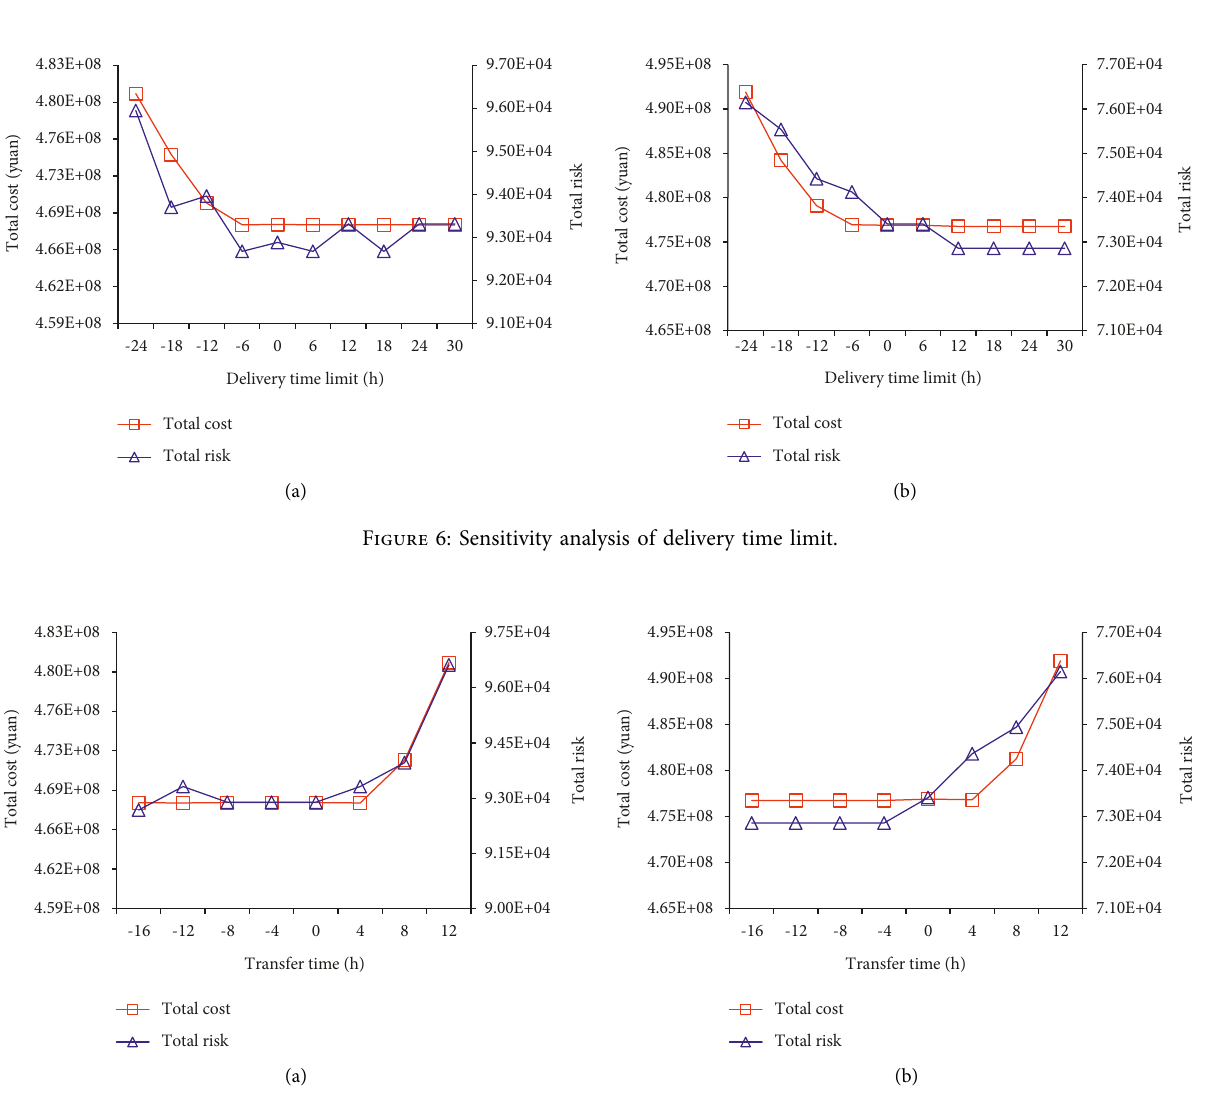
Figure 7: Sensitivity analysis of transfer time between railway and highway.